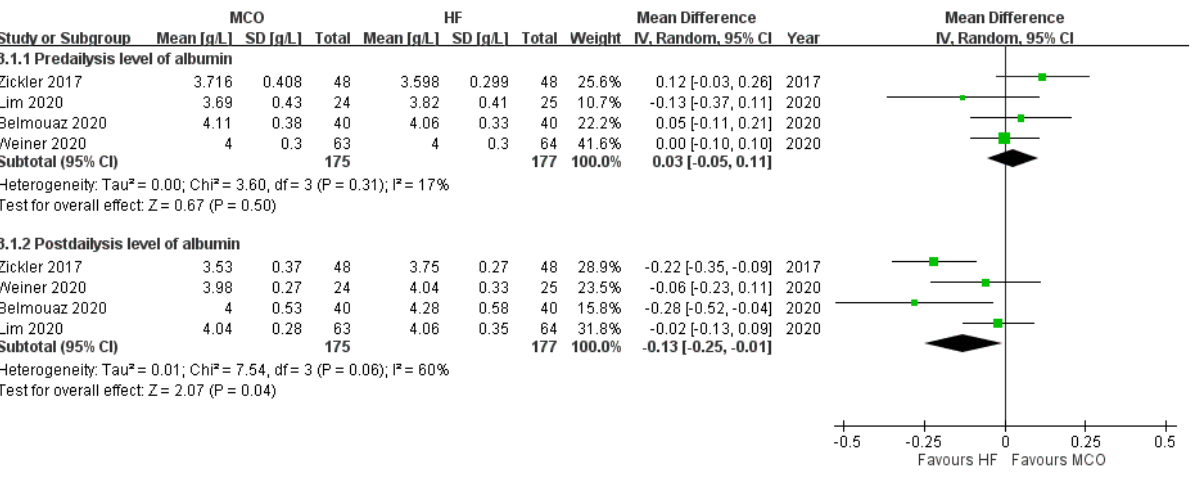
Figure 3. Albumin level before and after hemodialysis.